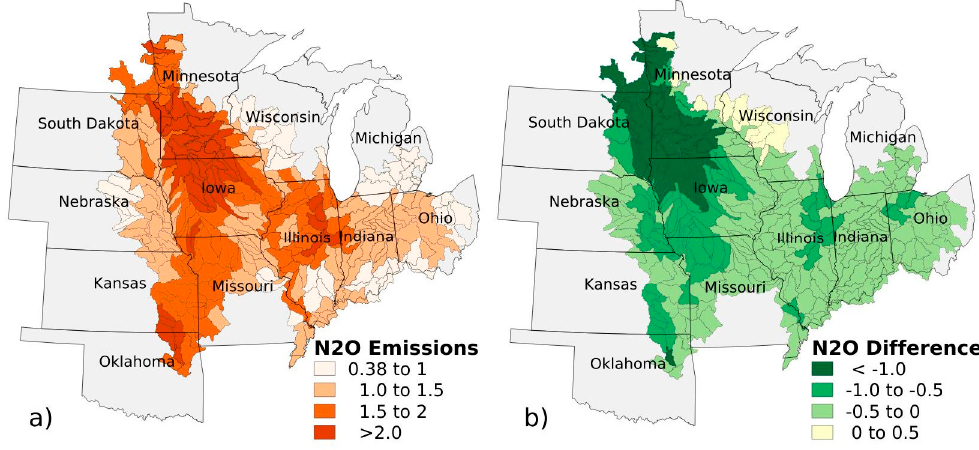
Figure 10. ( a ) Area-weighted mean annual N 2 O emissions (kgN / ha / yr) from 2005 to 2017 by HUC 8 in the Corn Belt, simulated with OpTIS-mapped management practices. ( b ) Di ff erence between OpTIS-mapped management and no SHM scenario N 2 O emission rates (kgN / ha / yr) between 2005 and 2017 by HUC 8.